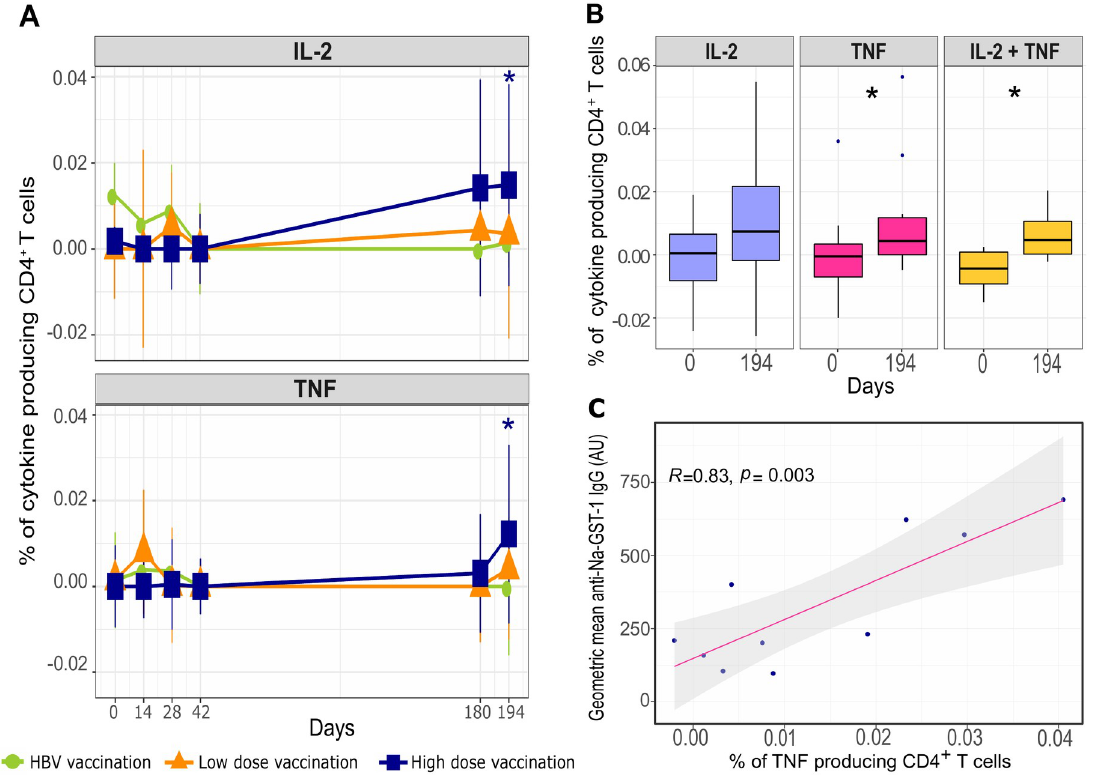
Fig 2. Cytokine responses to Na-GST-1 vaccination. (A) The frequency of IL-2 and TNF producing CD4 + T cells in response to Na-GST-1 stimulation, over time compared to baseline (day 0), in control (green line), low dose (orange line) and high dose group (blue line), using linear mixed model for statistical analysis. Cells producing cytokines are expressed as percentage of CD4 + T cells. The mean and standard deviation of cytokine producing cells is given for each time point and each vaccine group. (B) Frequency of CD4 + T cells producing IL-2 or TNF alone or together in response to Na-GST-1 on day 0 and day 194, in the high dose (100 μ g) group. Data are presented as boxplots representing the median, 1 st and 3 rd quantile. Whiskers are extending to the maximum/minimum, no further than 1.5x the IQR (interquartile range). Wilcoxon one-tailed paired test was performed for comparison between day 0 and day 194. (C) Correlation between the change induced by vaccination in Na-GST-1 specific IgG antibody levels and the frequency of TNF producing CD4 + T cells, in the high dose group (Spearman correlation test rho = 0.83, p = 0.003). The change in IgG and cytokine producing cells was determine by subtracting the baseline value (day 0) from day 194 value. The antibody levels are given as arbitrary unit (AU). The frequency of cytokine producing cells in ( A ), ( B ) and ( C ) was determined as percentage of total number of CD4 + T cell. ( � ) indicates the significance p � 0.05 in ( A ) and ( B